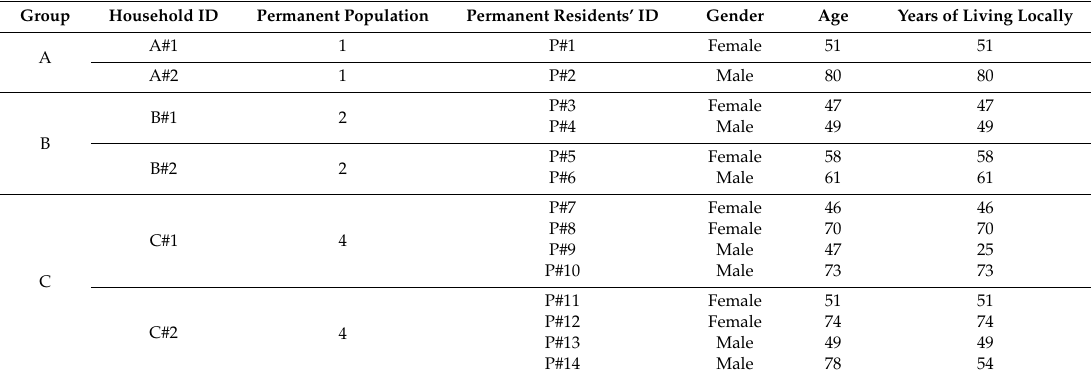
Table 1. Information on the 6 households and 14 permanent residents.